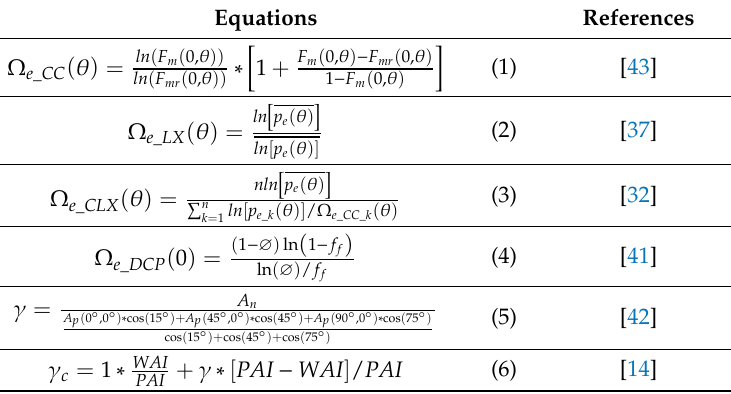
Table 1. Ω e and corrected needle-to-shoot area ratio ( γ c ) estimation formulae used in this study. γ is the needle-to-shoot area ratio. F m ( 0, θ ) is the measured total canopy element gap fraction at θ , F mr ( 0, θ ) is the total canopy element gap fraction after removing the large gaps resulting from the non-random distribution of the canopy element [39,40], p e ( θ ) is the canopy element gap fraction at θ , p e ( θ ) is the mean canopy element gap fraction of all segments at θ , ln [ p e ( θ )] is the mean logarithmic canopy element gap fraction for all segments at θ [37], n is the segment number, p e _ k ( θ ) is the canopy element gap fraction of segment k and Ω e _ CC _ k ( θ ) is the Ω e of segment k [32]. ∅ and f f are the crown porosity and foliage cover, respectively [41]. A n is half the total needle area in a shoot. A p ( 0 ◦ ,0 ◦ ) , A p ( 45 ◦ ,0 ◦ ) , and A p ( 90 ◦ ,0 ◦ ) are the shoot projection areas at azimuth angle 0 ◦ and zenith angles 0 ◦ , 45 ◦ , and 90 ◦ , respectively [42].